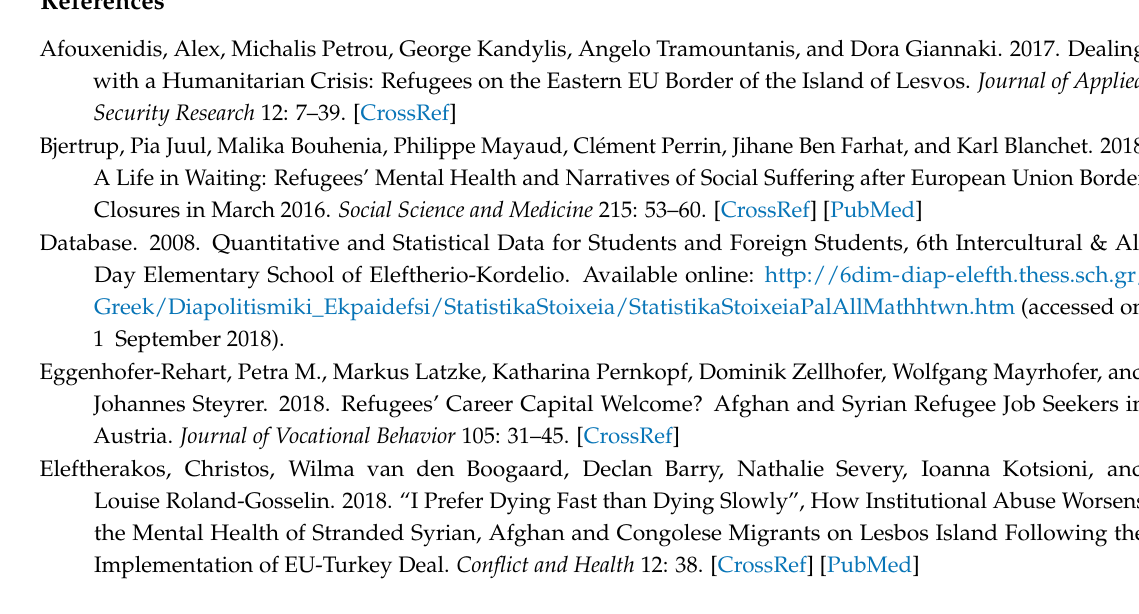
Figure S1: Initiatives of University of the Aegean (UAeg) related to the social integration of migrants, Table S1: Information Activities of University of the Aegean (UAeg) related to migrants support and